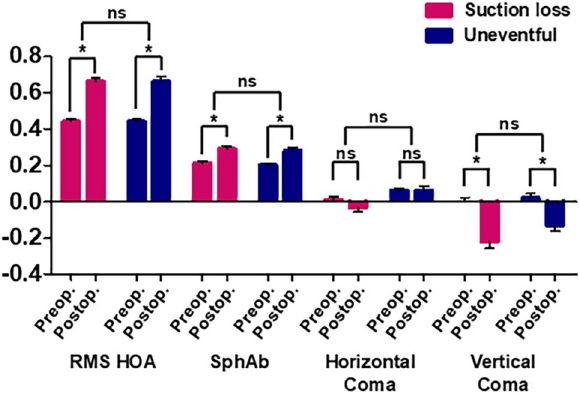
Figure 2. Changes in corneal higher-order aberrations (HOAs) at 6 months after uneventful small-incision lenticule extraction (SMILE) (Uneventful group) and immediate reapplication of the SMILE procedure after suction loss (Suction loss group). Data are presented as the mean ± standard error of the mean (SEM). RMS root mean square, SphAb spherical aberration, ns not significant. *Significant